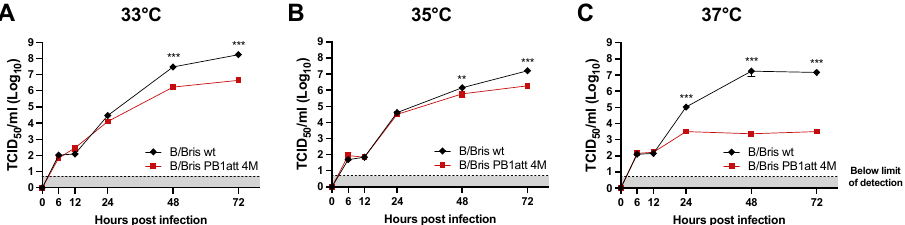
Figure 1. B/Bris PB1att 4M displays a temperature-sensitive phenotype in growth kinetics in vitro. MDCKs cells were inoculated with an MOI of 0.01 with B/Bris PB1att 4M and B/Bris wildtype (wt) strains and incubated at 33 ◦ C ( A ), 35 ◦ C ( B ), and 37 ◦ C ( C ). Supernatants were collected at 6, 12, 24, 48, and 72 h post-infection and viral titers were quantified by TCID 50 assays. The growth kinetics experiments were performed in triplicate and results represent an average of all experiments. Two-way ANOVA corrected for multiple comparisons using Sidak’s test was used to calculate p values. ** p < 0.01, *** p < 0.001. Plotted data represent means ± standard